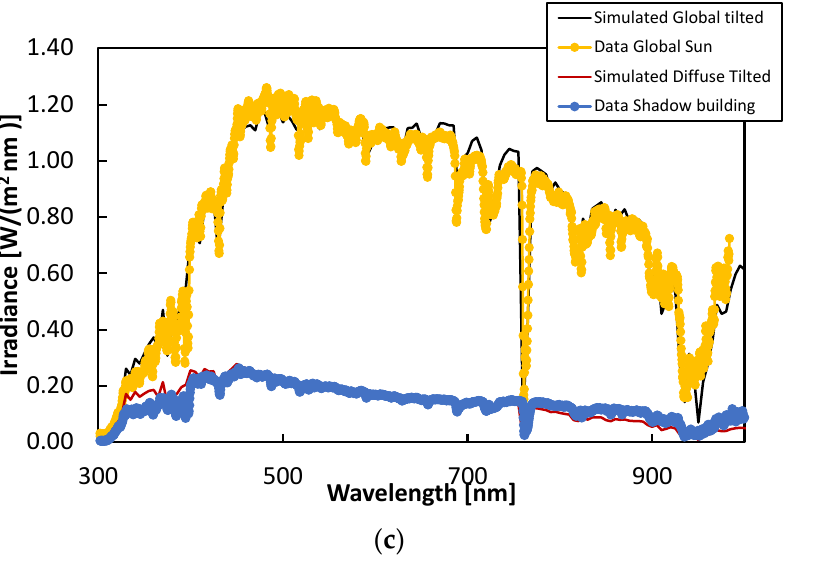
Figure 3. ( a ) Global and ( b ) diffuse irradiance spectra as calculated by the SMARTS simulation toolkit [28] in the case of different AM values and clear sky. ( c ) Spectra measured in clear sky and in shadows due to a building are compared with the simulated global and diffuse tilted irradiance using the same toolkit for the corresponding AM = 2.5, considering a concrete building environment and clear sky.